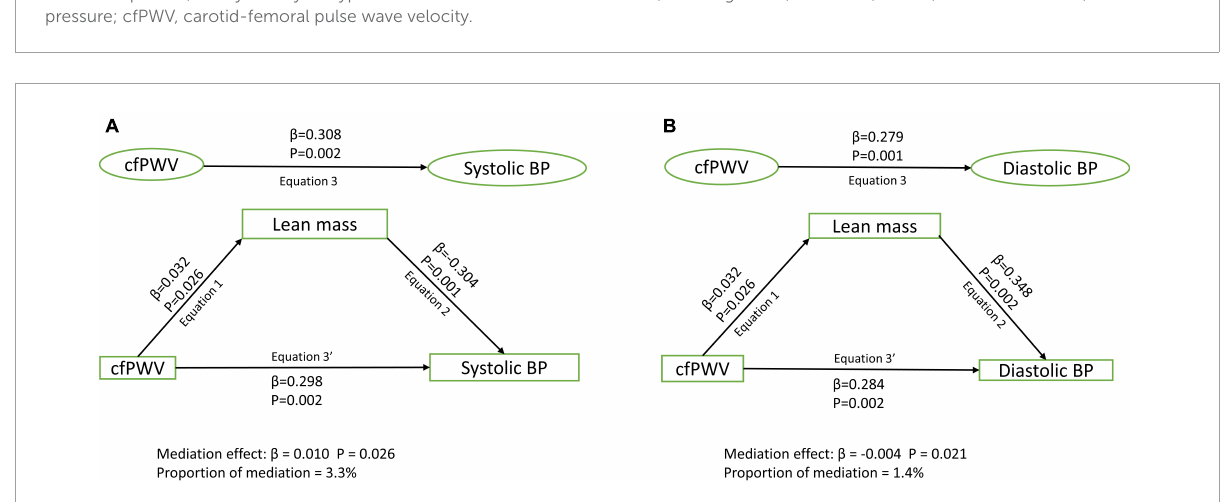
FIGURE2 Mediating role of lean mass on the associations of arterial stiffness with systolic blood pressure (A) and diastolic blood pressure (B) . Mediating path analyses were adjusted for age, sex, high-density lipoprotein cholesterol, low-density lipoprotein cholesterol, triglyceride, high-sensitivity C reactive protein, family history of hypertension and cardiovascular diseases, smoking status, heart rate, insulin, and fat mass. BP, blood pressure; cfPWV, carotid-femoral pulse wave